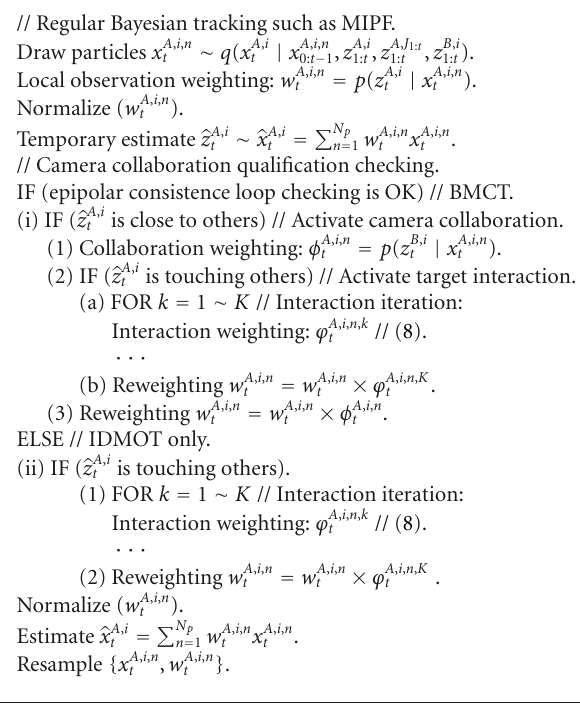
Algorithm 1: Sequential Monte Carlo implementation of BMCT